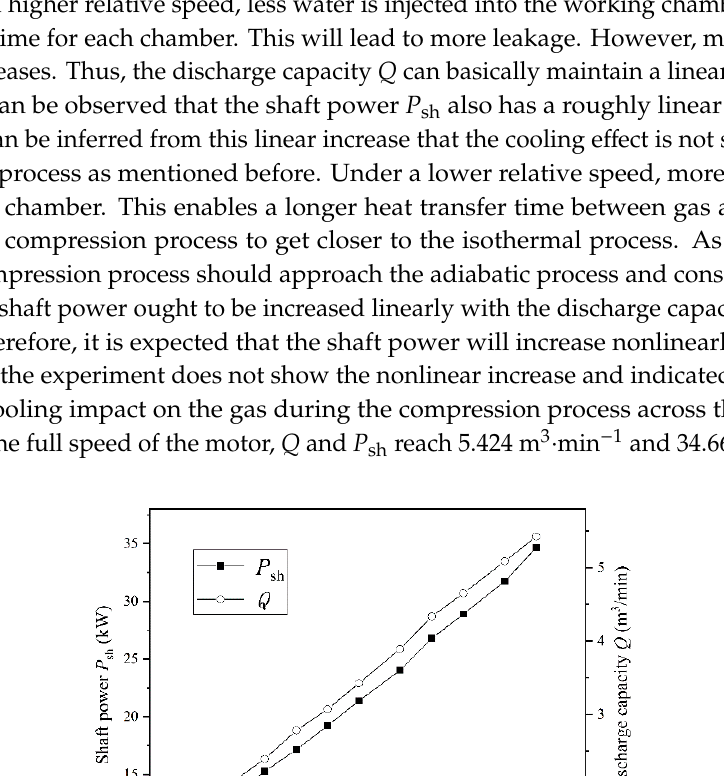
Figure 10. The compressor performance under different motor speed.